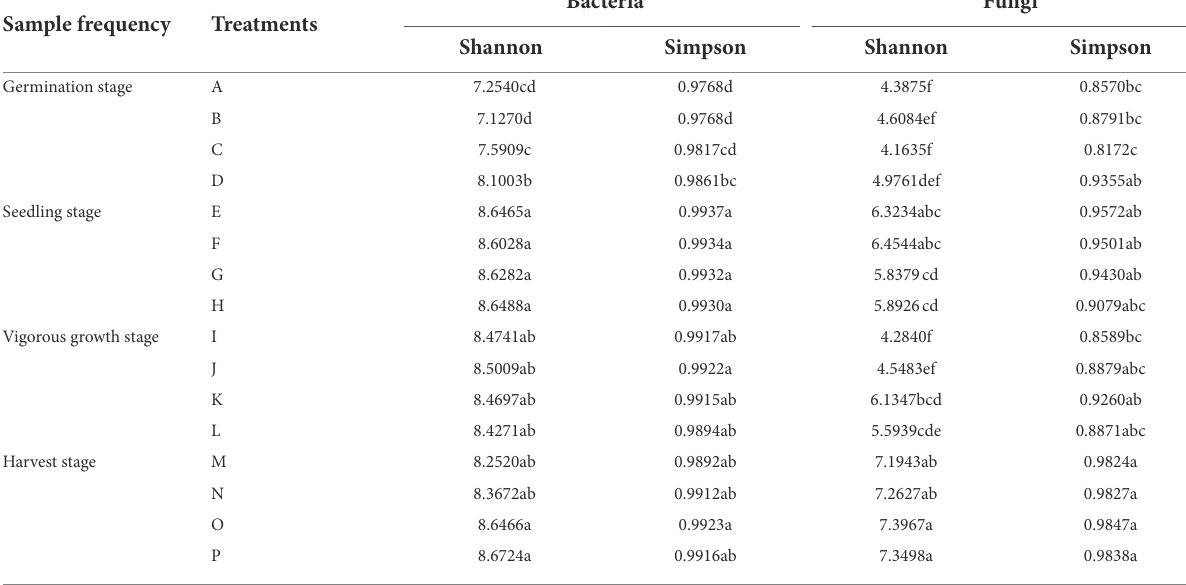
TABLE 2 The Shannon-Wiener and Simpson’s diversity indices of soil microorganisms at different developmental stages.